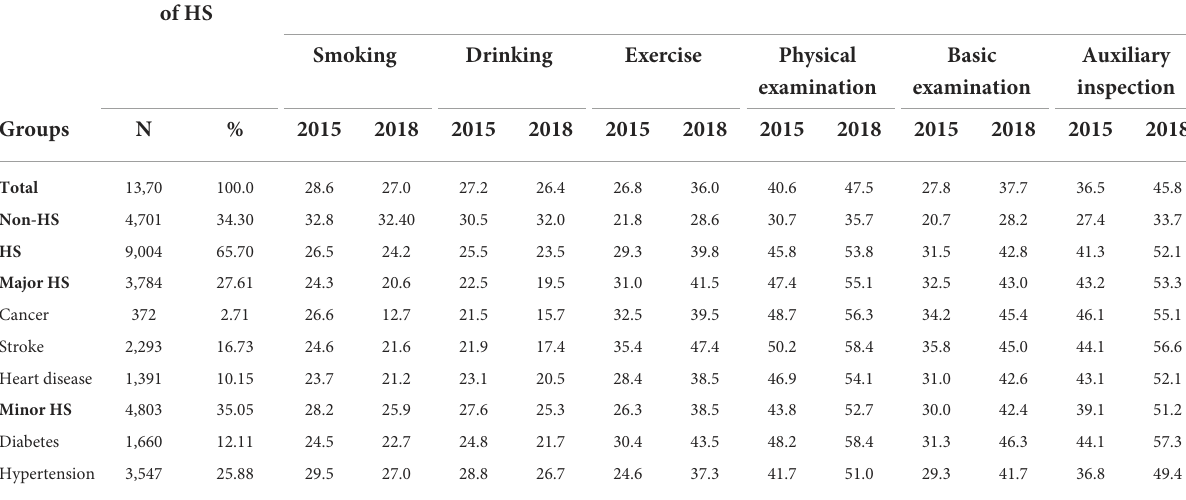
TABLE 2 The occurrence of HS during 2015 to 2018 and preventive behaviors before and after HS in different groups. The occurrence of